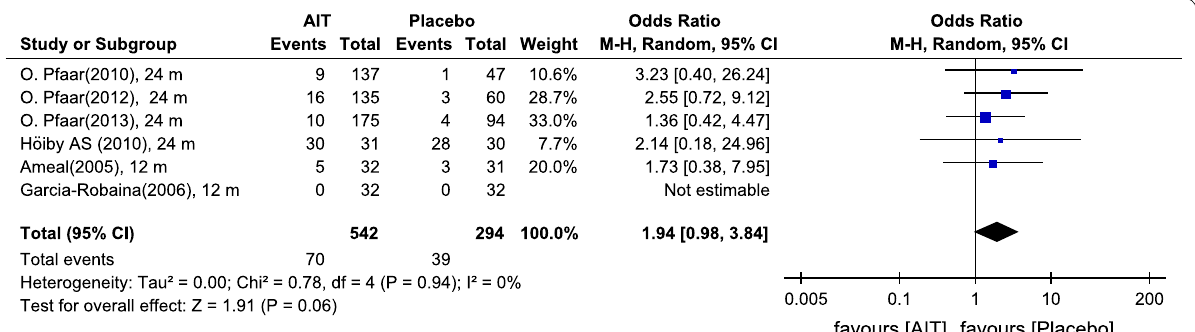
Fig. 8 Odds rations for systemic reactions under AIT with DPAEs and placebo. Data extracted from the original studies. Outcome: number of patients developing systemic reactions after immunotherapy administration. AIT allergen‑specific immunotherapy, CI confidence interval, m months